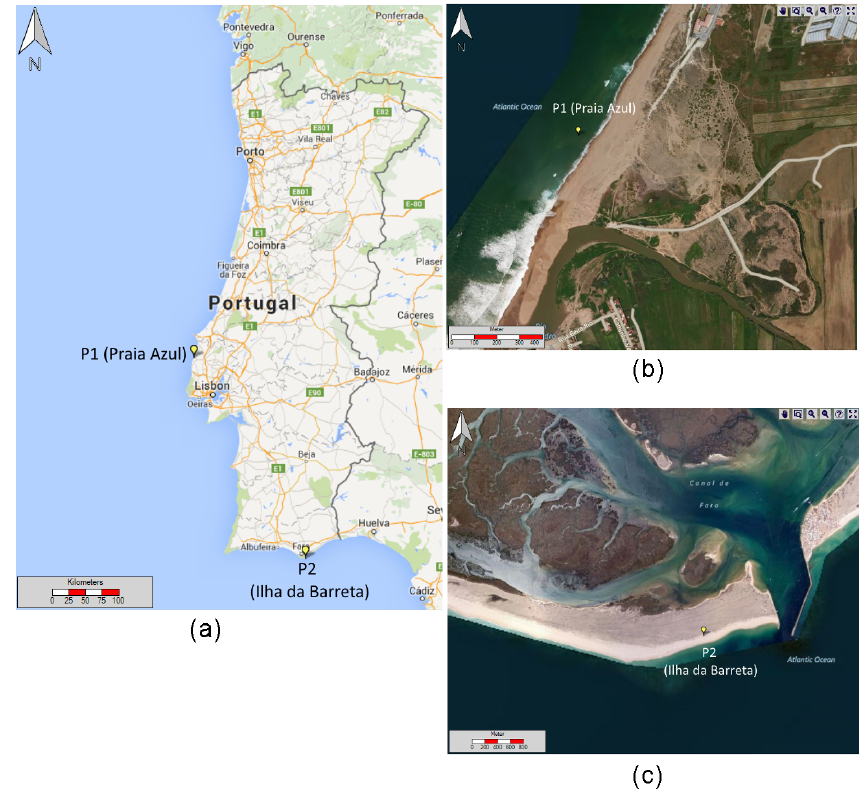
Figure 7. Location points for the shoreline contamination risk detailed study. (a) Location map; (b) aerial view from P 1 (Praia Azul) and (c) aerial image from P 2 (Ilha da Barreta).